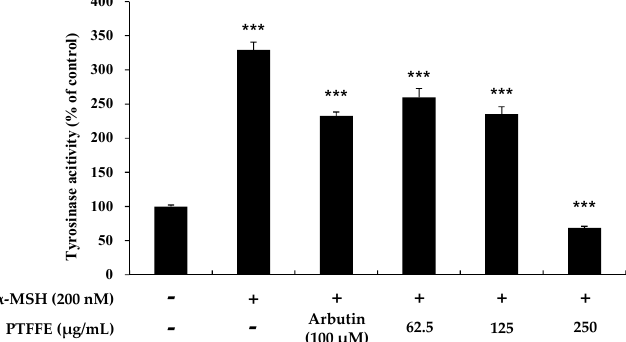
Figure 3. Effects of PTFFE on tyrosinase activity. B16F10 melanoma cells were treated with PTFFE at the indicated concentrations for 72 h. α-MSH (200 nM) and arbutin (100 μM) were used as a positive and negative control, respectively. The results are expressed as percentages of the untreated cells. The data are presented as the mean ± SD of at least three independent experiments. *** p < 0.001.